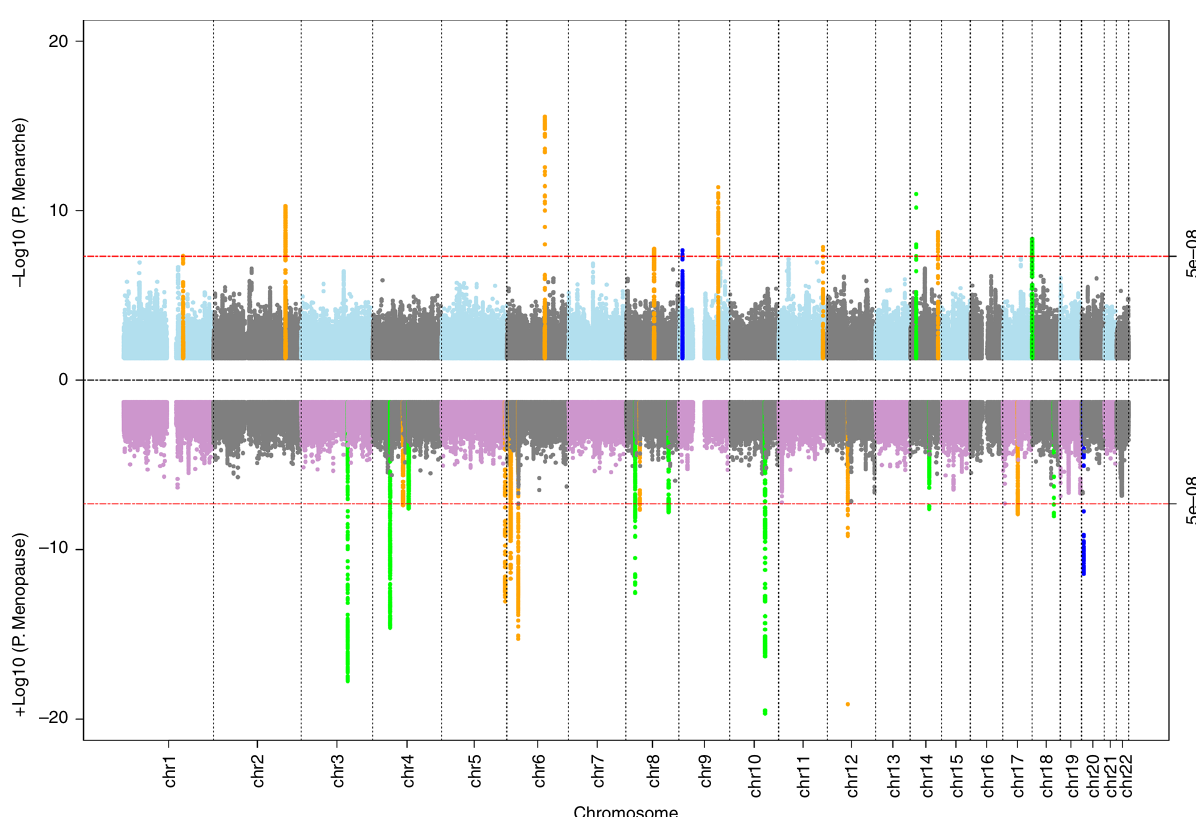
Fig. 1 ‘ Miami ’ plot showing genome-wide association test statistics for ages at menarche (top) and menopause (bottom) in the BioBank Japan Project. Genome-wide signi fi cant loci in BBJ are highlighted according to: novel loci (green), novel signals at known loci (blue) and known loci